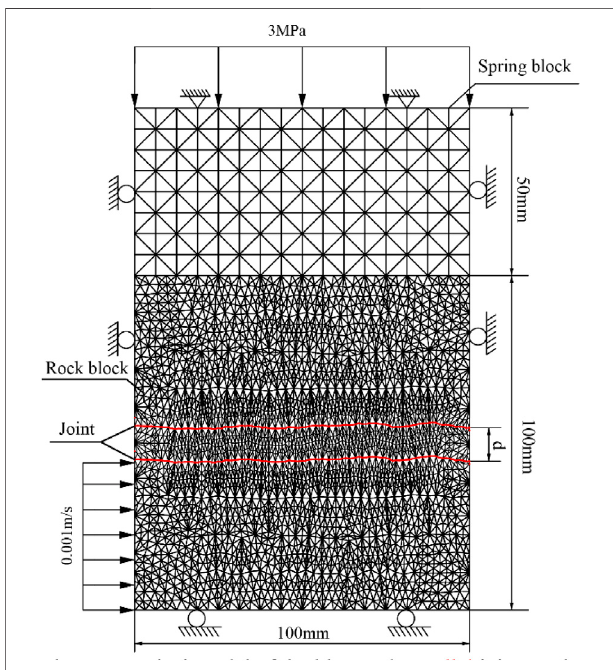
FIGURE 3 | Direct shear numerical model of double rough parallel joints under CNS